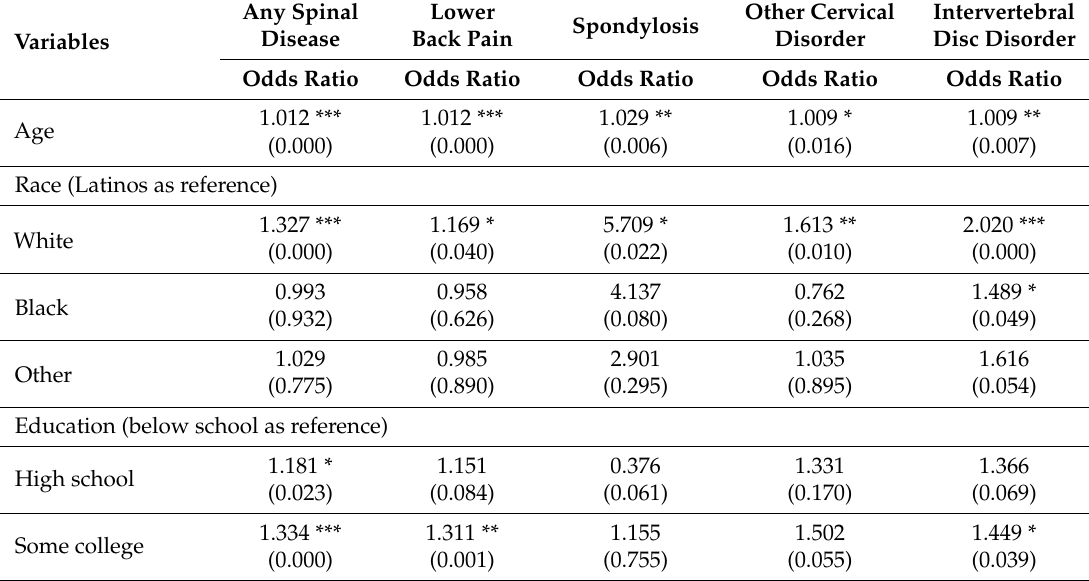
Table 3. Weighted logistic regressions of bodyweight status and spinal diseases (N =